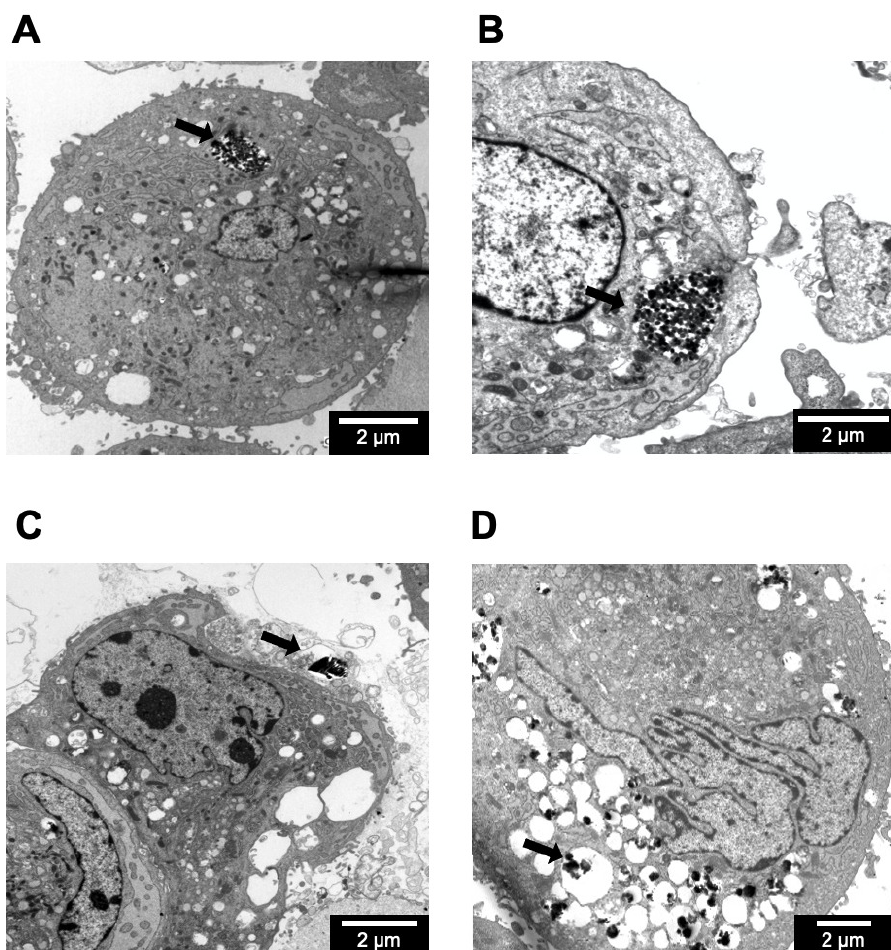
Figure 8. Ultrastructural features of zeolite particle uptake by IMR-90 cells. The transmission electron micrographs show thin sections with zeolite particle-exposed IMR-90 cells. The cells were cultured in the presence of ( A ) 50 µ g/mL LTL-R, ( B ) 50 µ g/mL MFI-S, ( C ) 50 µ g/mL LTL-D, and ( D ) 50 µ g/mL FAU-S for 72 h. The zeolite particles (arrow) were located as ( A , B ) aggregates in intracytoplasmic phagosome, ( C ) aggregates in submembranous phagosome, and ( D ) small aggregates in numerous cytoplasmic